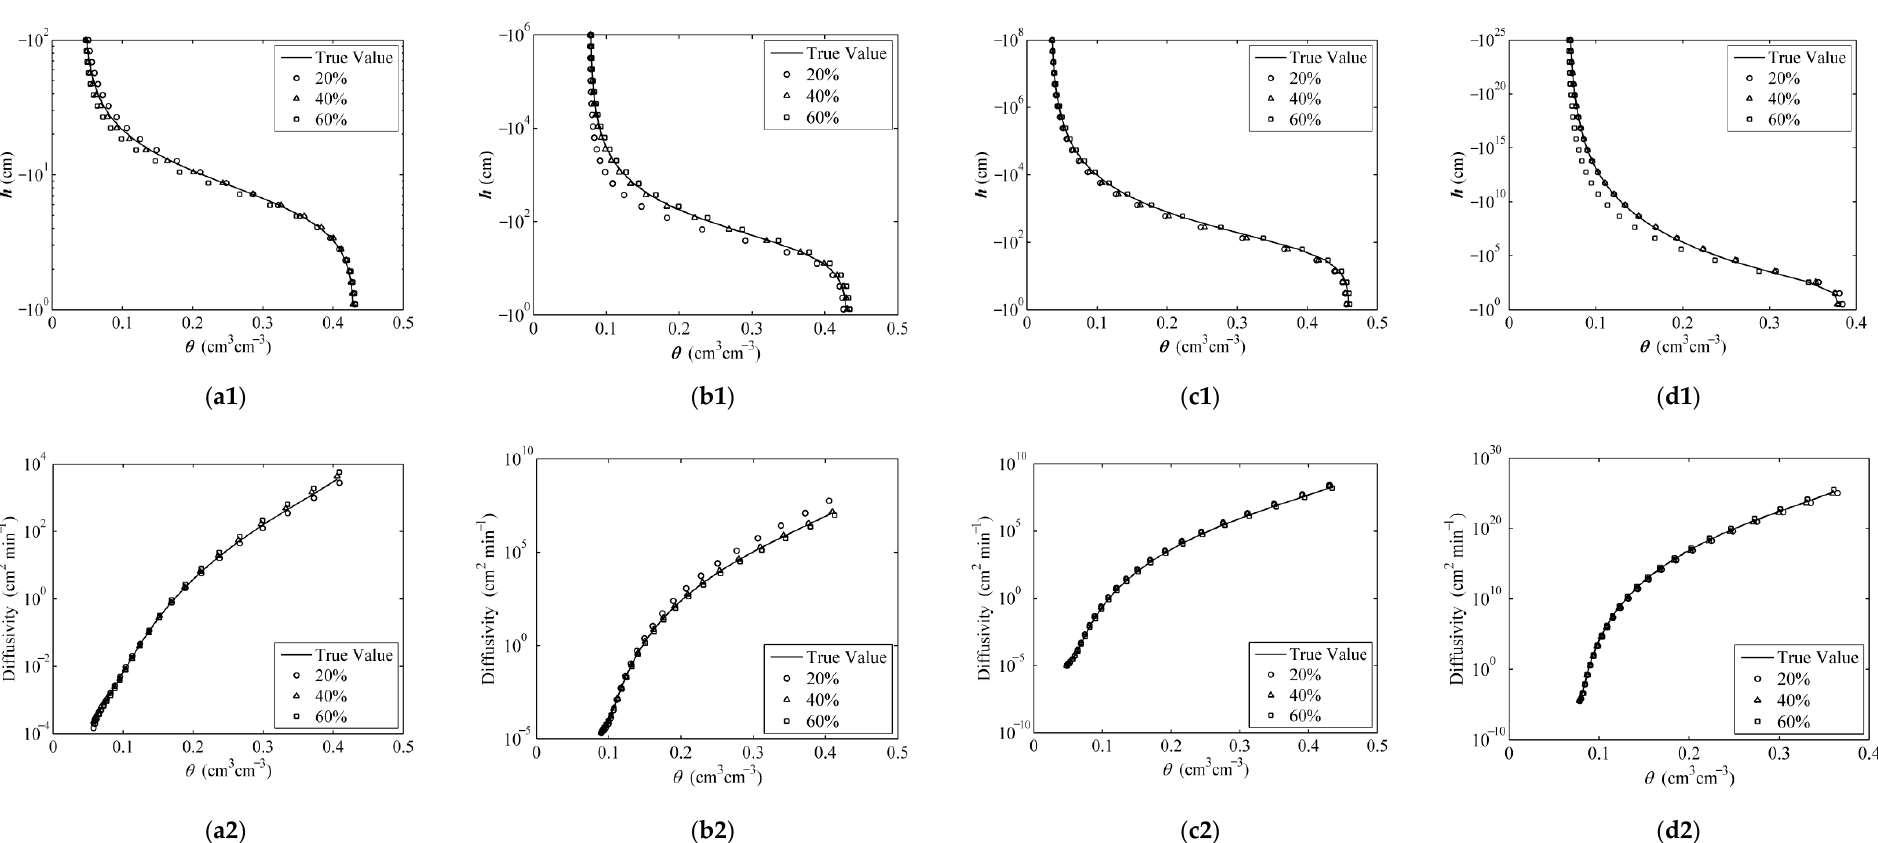
Figure 7. Comparison of soil water retention curves ( a1 , b1 , c1 , d1 ) and diffusivity curves ( a2 , b2 , c2 , d2 ) for various treatments (circle: 20% effective saturation; triangle: 40% effective saturation; square: 60% effective saturation; line: true value): ( a ) sand; ( b ) loam; ( c ); silt, and ( d ) clay. The ranges of y-axis vary depending on the different soil textures.